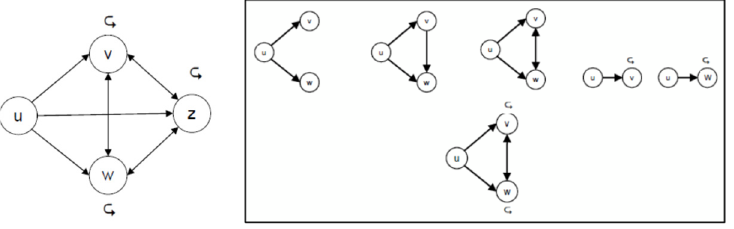
Figure 12. ( Left ): Representation of a KD45 modal system for a four-state world W, where the frame sub-class { u , w , z } constitutes an equivalence class generated by only one inaccessible world-state { u } . KD45 constitutes a “secondary” or generated S5 system. ( Right ): Oversimplified calculus of relations underlying a three-state world W for a generated S5 system, where the accessibility relations from an inaccessible world-state { u } generates the equivalence sub-class { v , w } (see